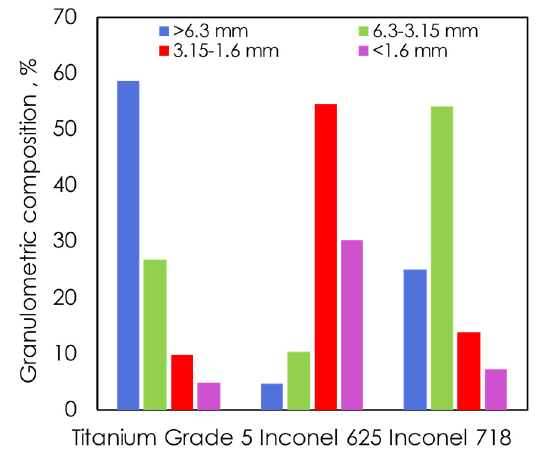
Figure 2. Granulometric composition of alloys after sieve analysis.